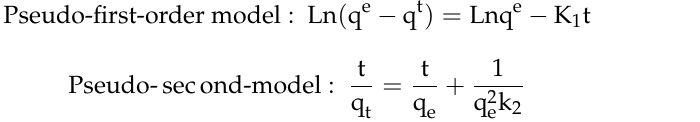
Adsorbents Magnetic attapulgite composites 189.0 142.8 [33] Novel geogolymers based on coal gangue and red mud 90.0 137.7 Tetrazole-bonded bagasse 253.5